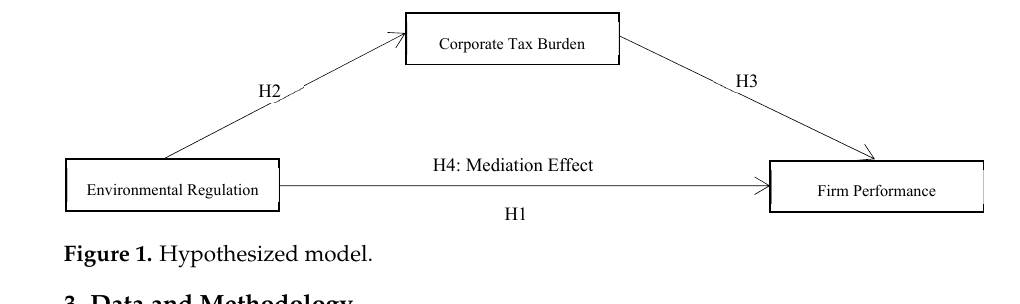
Figure 1. Hypothesized model.